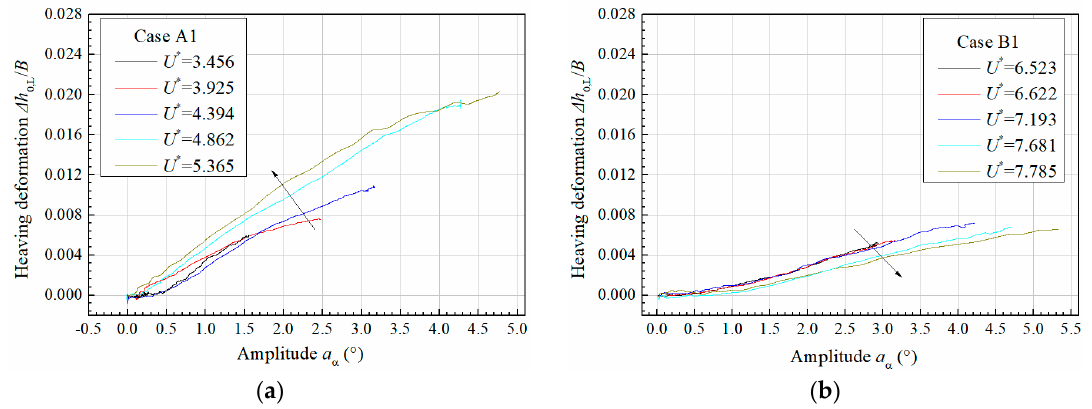
Figure 17. Evolution of additional heaving drift along with torsional amplitude for ( a ) attack angle 3° and ( b ) attack angle 0°.